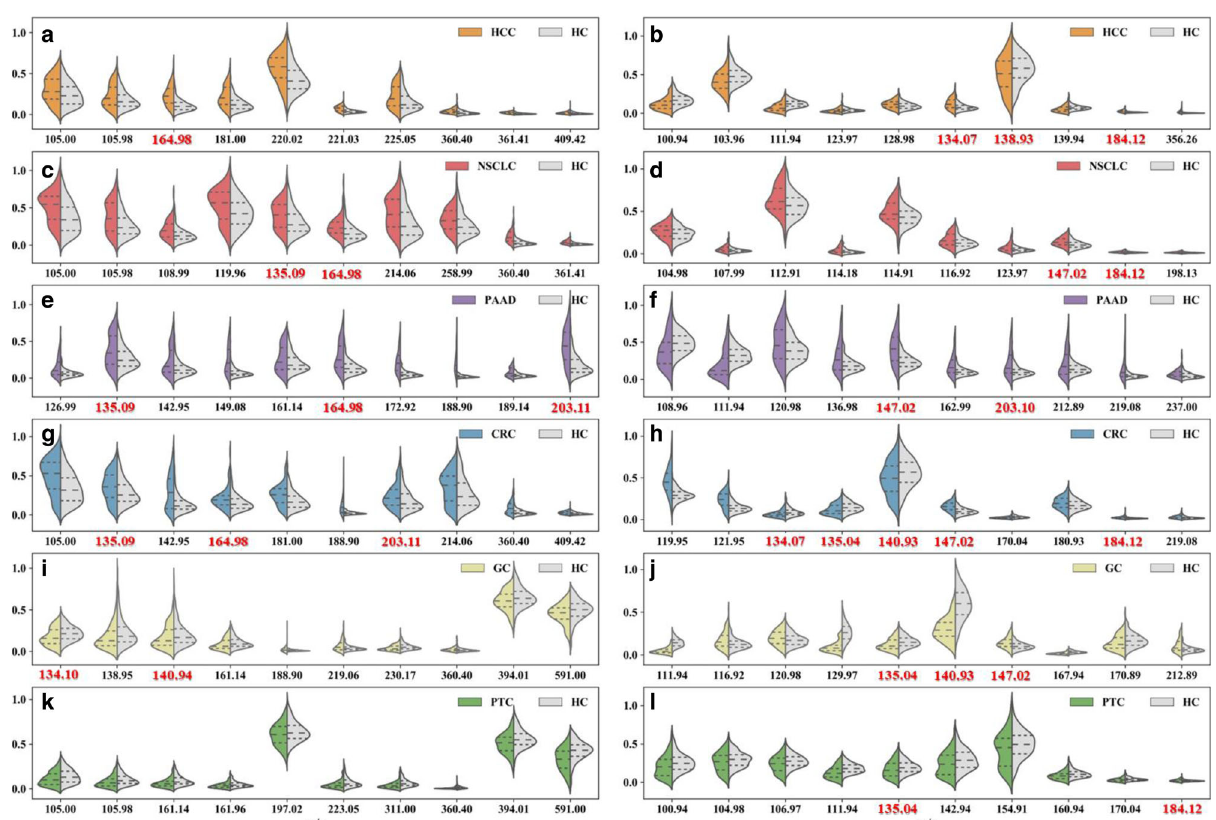
Fig. 3 Discriminating features of each cancer type versus healthy controls. Violin plots of top 10 m/z LDI intensity distributions of each cancer type vs healthy control chosen by MNALCI. (The middle dash lines indicated median value of the LDI intensities of each corresponding m/z while the upper and lower dotted lines indicated intensity values of fi rst quartile and third quartile. Gray represented healthy control while the colored represented cancer patients). a HCCs vs healthy controls by GNS-assisted LDI. b HCCs vs healthy controls by SiNW- assisted LDI. c NSCLCs vs healthy controls of